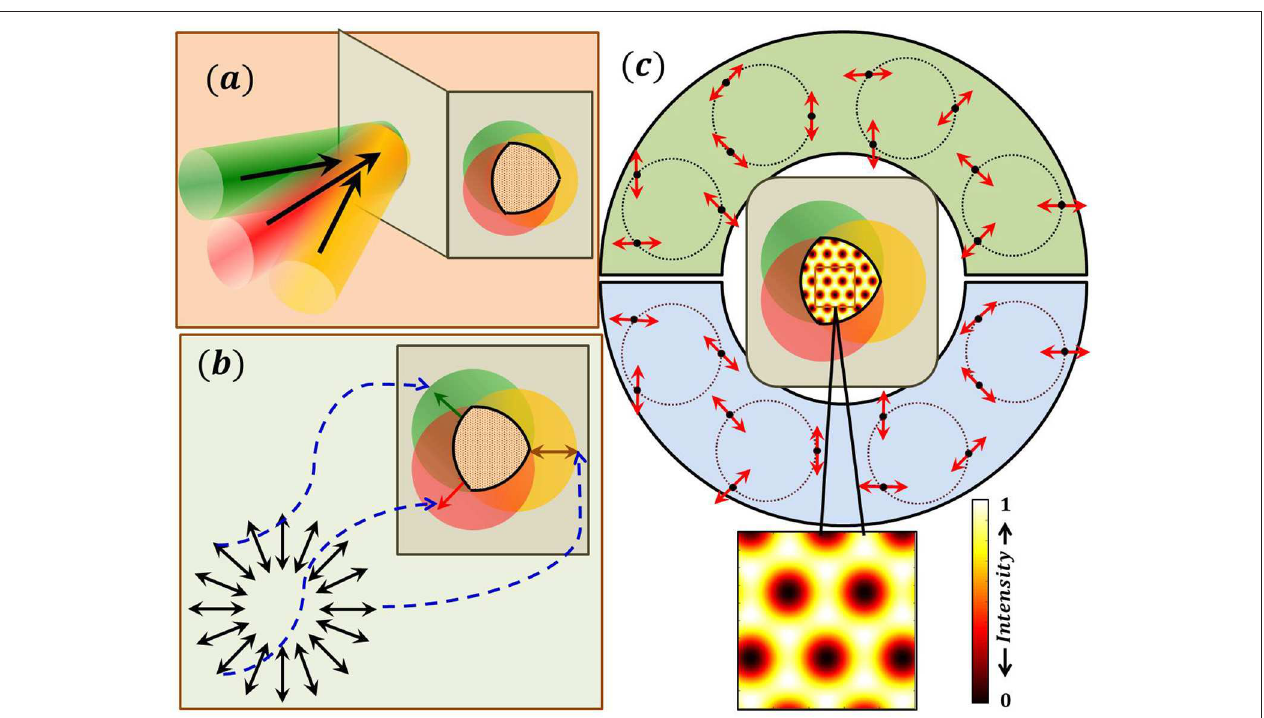
FIGURE 2 | (a) Schematic showing three non-coplanar plane wave interference. (b) The SOPs of the three interfering beams are different and are chosen from a SOP distribution of that of a radially polarized beam. (c) In the region where the three beams overlap polarization singularity lattice is produced. The intensity pattern is same (degenerate) if the SOPs of the three interfering beams are chosen from any one of the depicted sets. In fact, the set can be chosen from any polarization distribution that has same magnitude of η to produce degenerate intensity